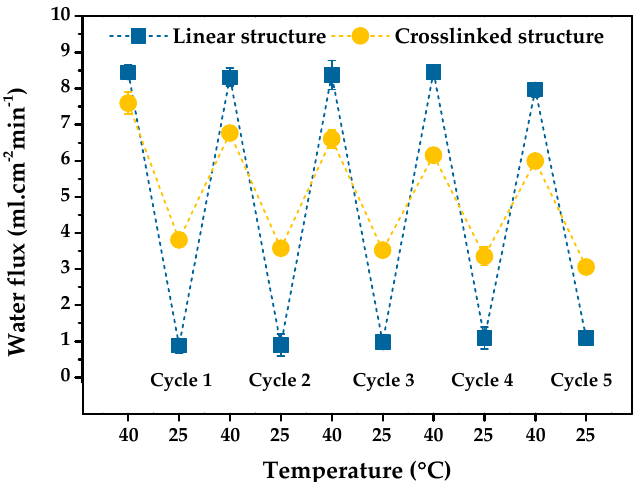
Figure 9. Reversibility of the thermoresponsive “open-closed” switching function of the grafted PNIPAm gates in the membrane pores under the test pressure of 100 kPa. (The optimum grafting yield of 22.5 and 21.9% is for the linear and crosslinked PNIPAm structures. )